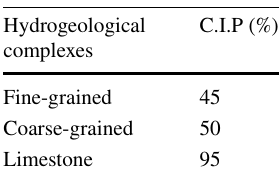
Table 2 (e.g., porosity and permeability (Viaroli et al. 2018; Celico 1988).